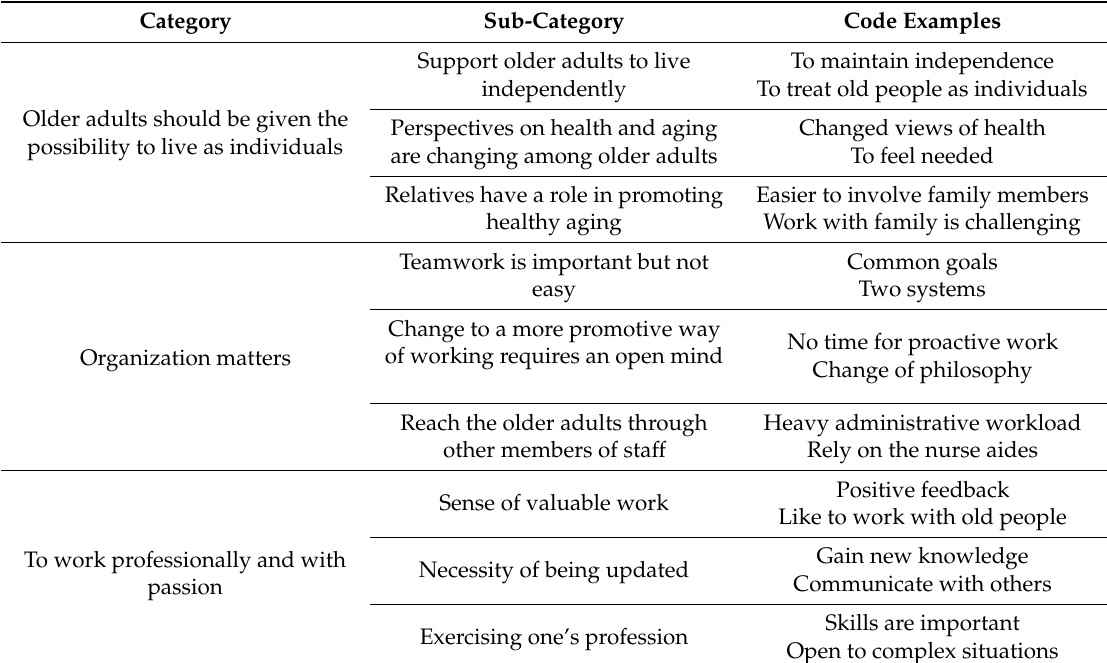
Table 1. Nurses’ experiences of promoting healthy aging-an overview of categories, sub-categories, and code